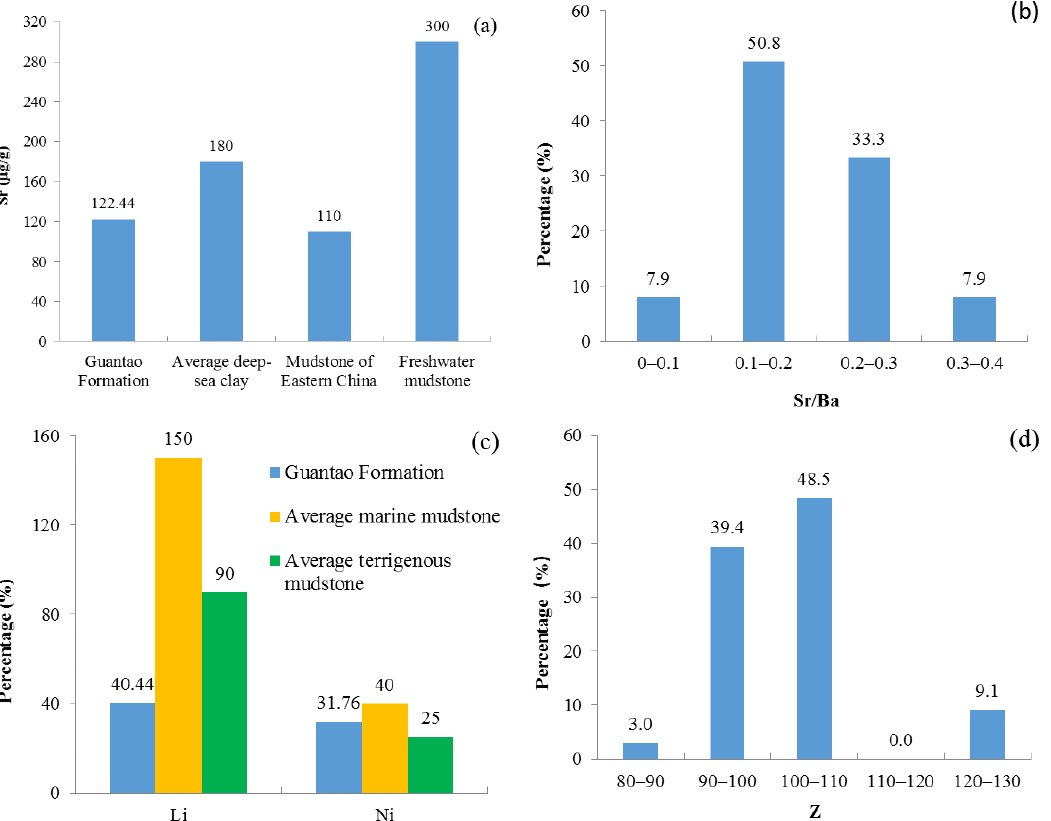
Figure 6. ( a ) Comparison diagram of Sr content of the Guantao Formation with average marine mudstone [43], mudstone of Eastern China and freshwater sediments [58]. ( b ) Distribution histogram of Sr/Ba ratios. ( c ) Comparison diagram of Li and Ni content of the Guantao Formation with the average marine mudstone [43] and the average terrigenous mudstone [58]. ( d ) Z value distribution histograms of the Guantao Formation.